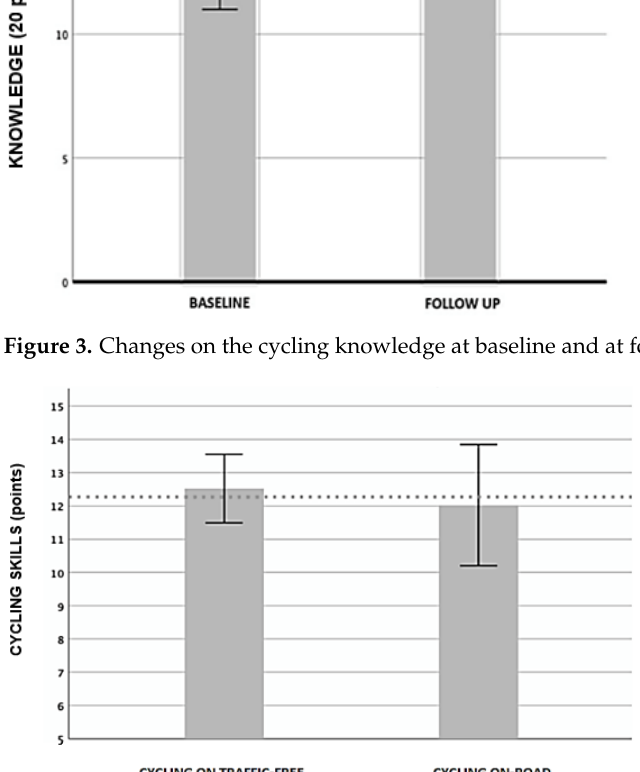
Figure 4. Descriptive data of the cycling skills in the cycling group.